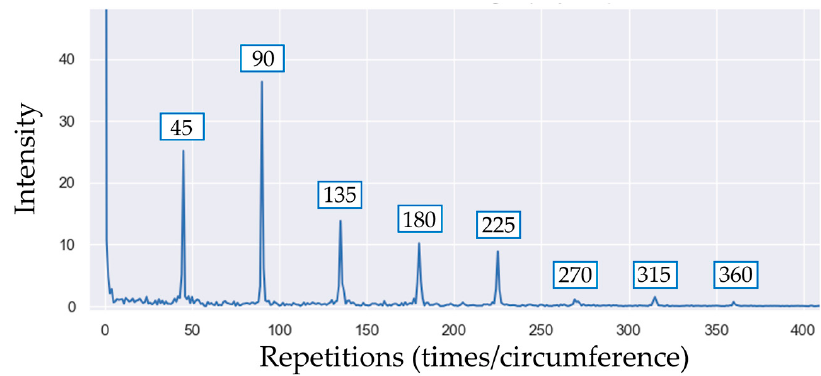
Figure 9. Angular frequency analysis of the pseudo signal shown in Figure 8.